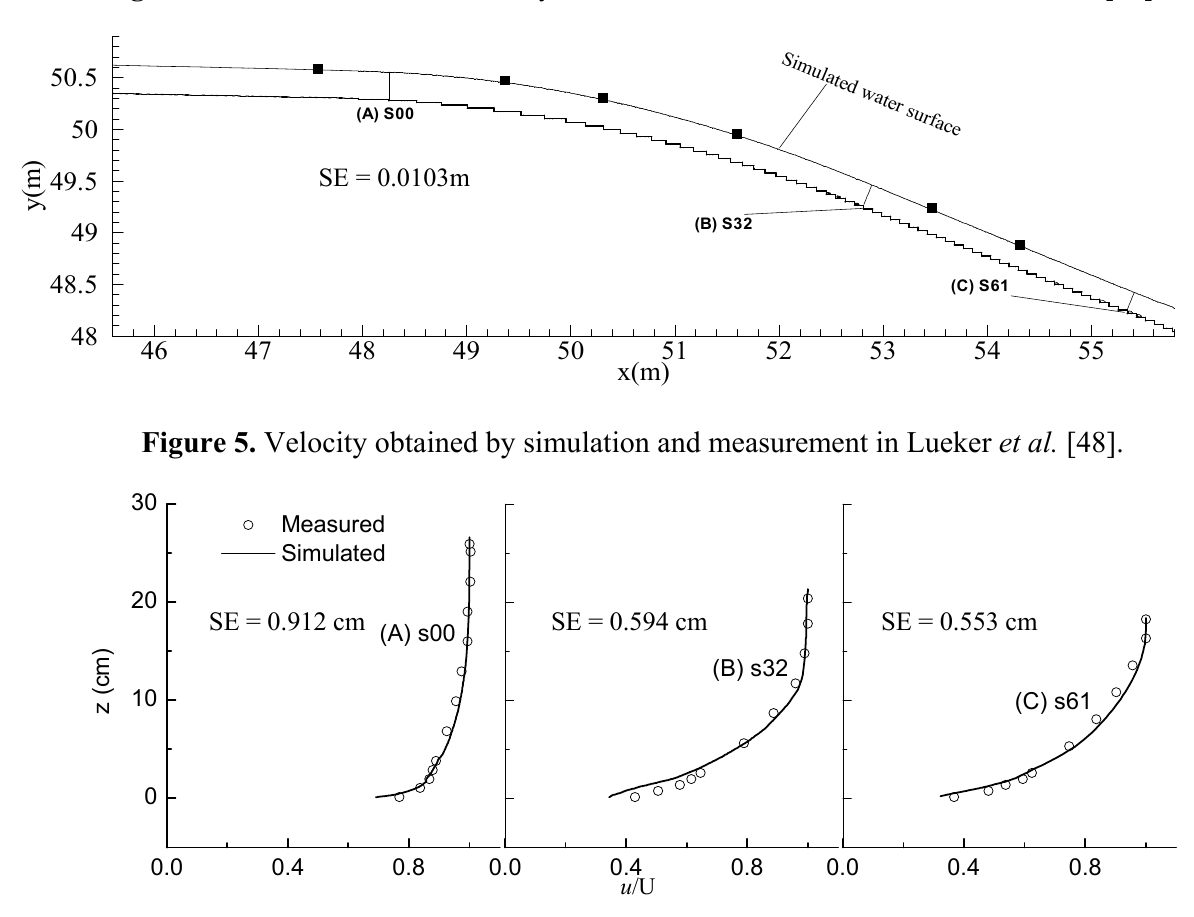
Figure 6. Velocity obtained by simulation and measurement in Hunt and Kadavy